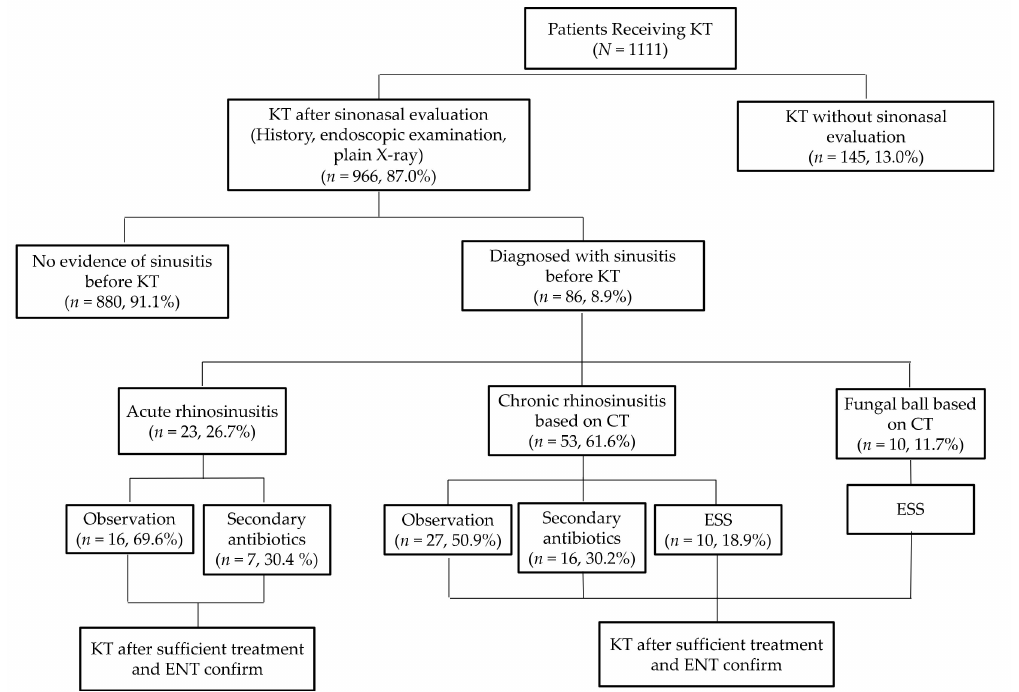
Figure 1. Flowchart of patients who underwent a sinonasal evaluation before kidney transplantation. KT, kidney transplan- tation; ENT, ear, nose, and throat specialist (otorhinolaryngologist); OMU CT, ostiomeatal unit computed tomography; ESS, endoscopic sinus